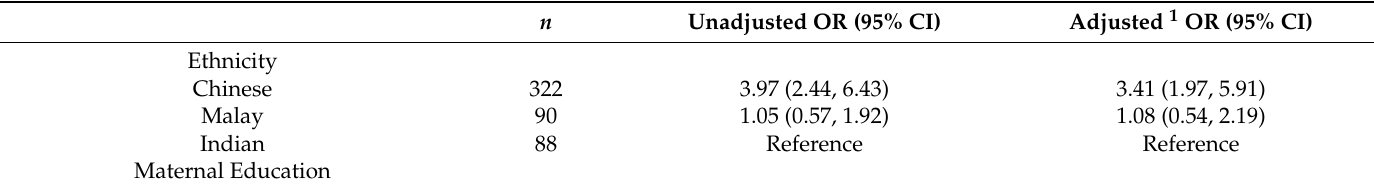
Table 2. Factors independently associated with increasing levels of breast milk expression at three months post-delivery ( n =